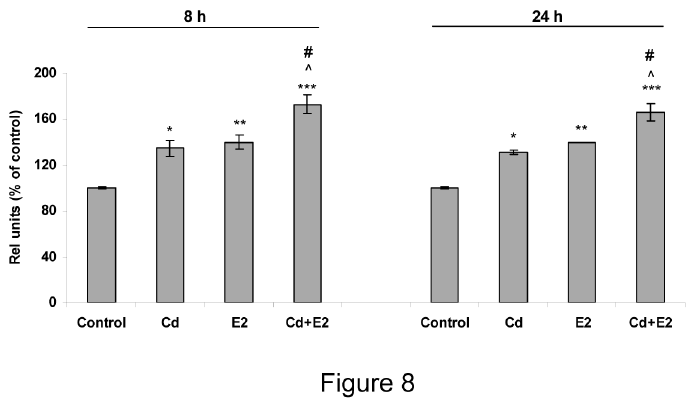
Figure 8. Additive effect of cadmium and E2 co-treatment on ERα mRNA expression. Anterior pituitary cell cultures were treated with vehicle (control), 10 nM Cd or 1 nM E2 or 10 nM Cd plus 1 nM E2 for 8 h or 24 h. ERα mRNA expression was evaluated by PCR. Bars represent the mean ± SE of densitometric values normalized to GAPDH. ANOVA followed by Tukey- Kramer’s test, *p<0.05, p<0.01, p<0.001 vs. Control; #p<0.05 vs. Cd; ^ p<0.05 vs. E2 (N=3).